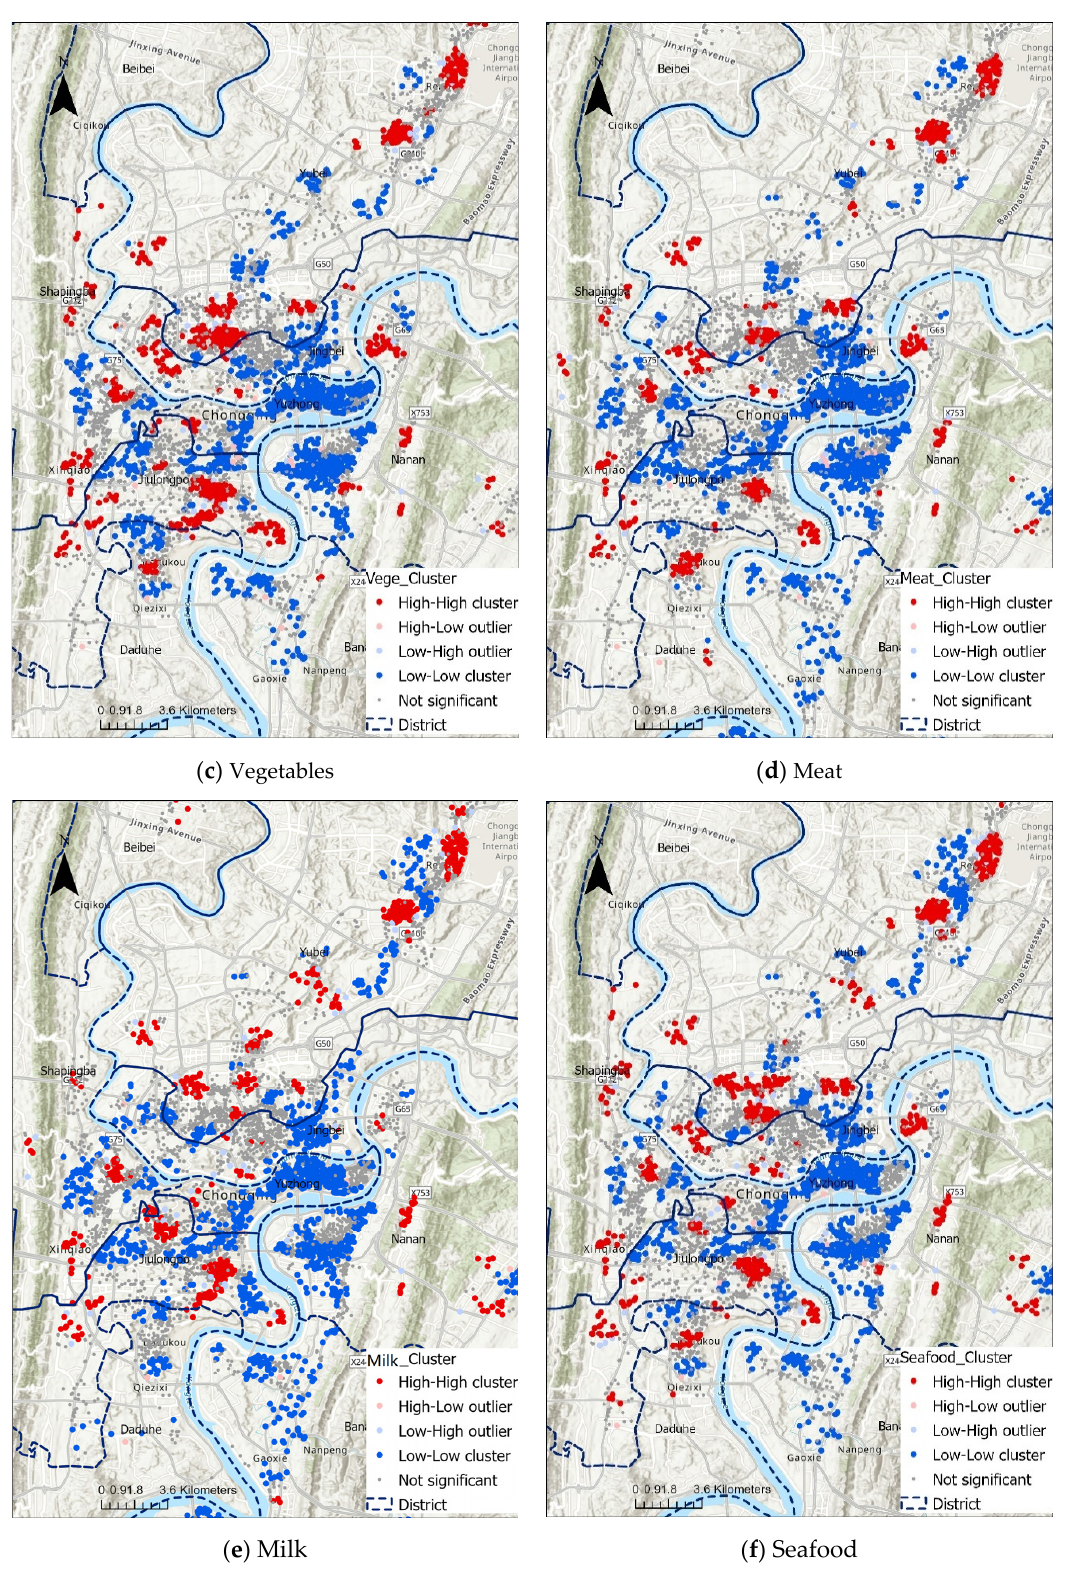
Figure 11. Local Moran’s analysis of different food types in Chongqing.